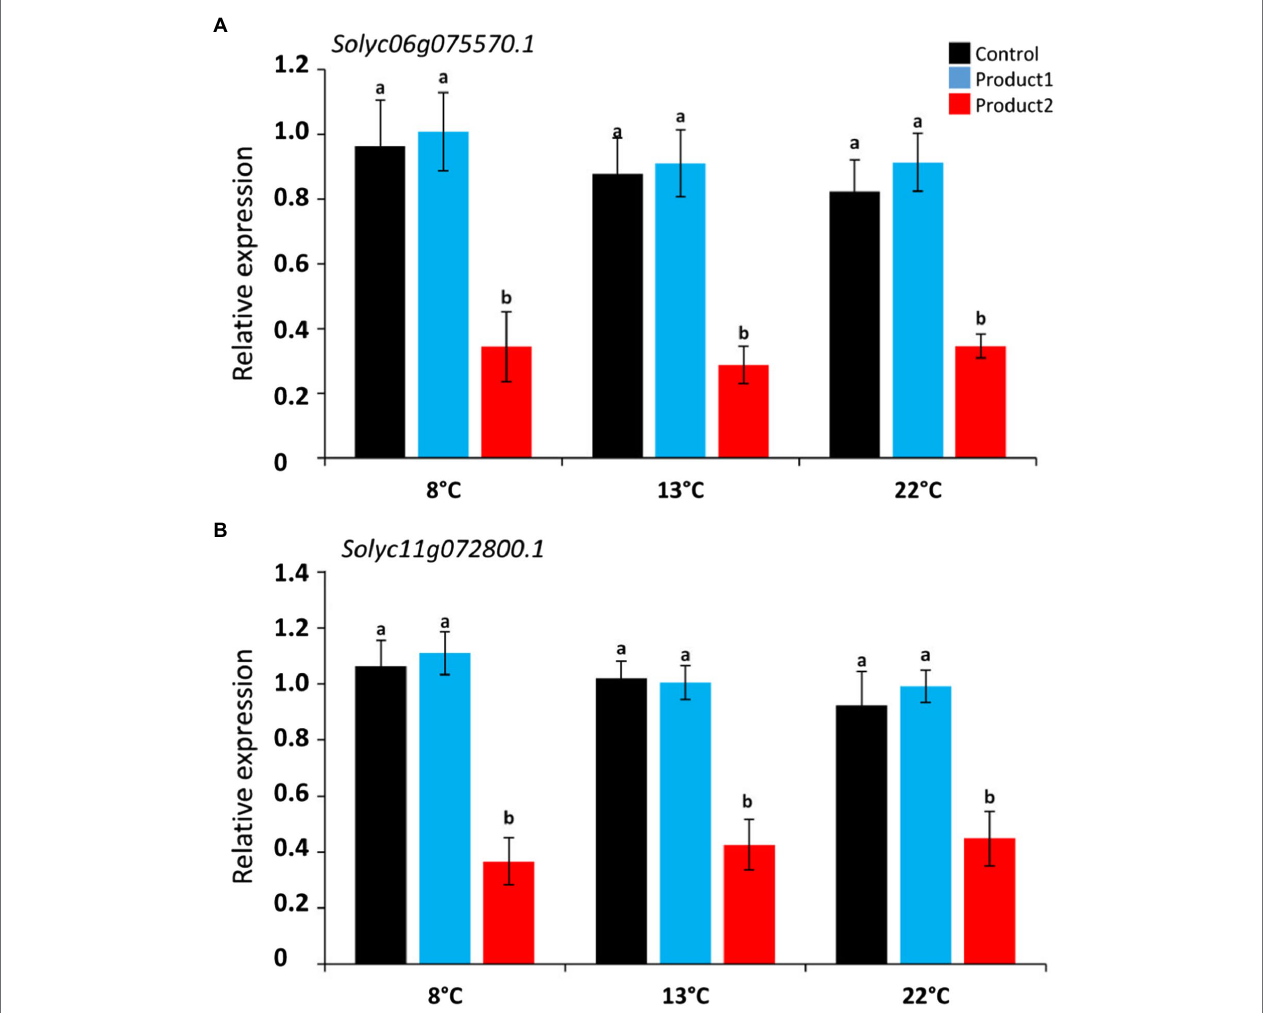
FIGURE 7 | Relative expression of NADPH oxidase genes: Rboh1 and Rboh2 cultivated for the durations corresponding to D 8 ° C, D 13 ° C, and D 22 ° C. (A) Relative expression of Rboh1 ( Solyc06g075570.1 ). (B) Relative expression of Rboh2 ( Solyc11g072800.1 ). Different colors correspond to pollen tubes cultivated in control condition (black), or in a medium supplemented with 2 μ g.ml − 1 of P1 (blue) or P2 (red) at 8, 13, and 22 ° C. Relative expression corresponds to the mean of six biological replicates normalized against four reference genes ( EXP , LZ , EF1 α , and CK2A ). Statistical analyses were carried out by one-way ANOVA, and significant differences were analyzed by Dunnett’s multiple comparison test. Data are marked by different letters when significantly different to the control conditions at each temperature ( p <